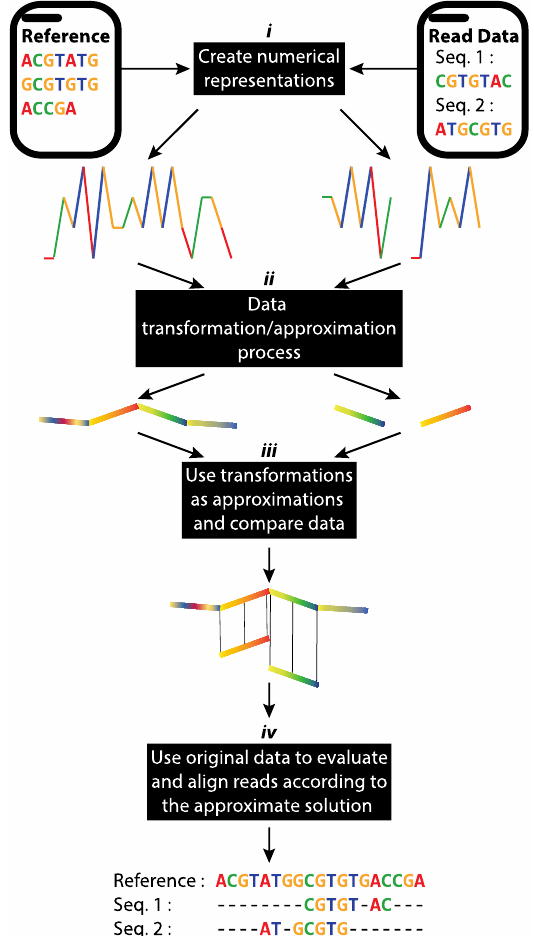
Figure 2. Overview of our proposed methodology using time series transformation/approximation methods: ( i ) Creation of numerical representations of input sequences. ( ii ) Application of an appropriate signal decomposition method to transform sequences into their feature space. ( iii ) Use of approximated transformations to perform rapid data analysis in lower dimensional space. ( iv ) Validation of inferences against original, full-resolution input sequences. In the case of reference-based alignment and taxonomic classification, approximated read transformations were compared with a reference sequence. In our de novo implementation, pairwise comparisons were performed between all of the approximated read transformations.